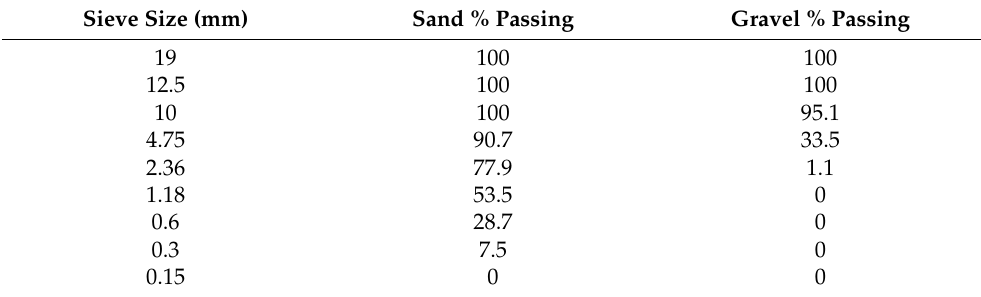
Table 3. Grading of sand and gravel used for NC specimens.